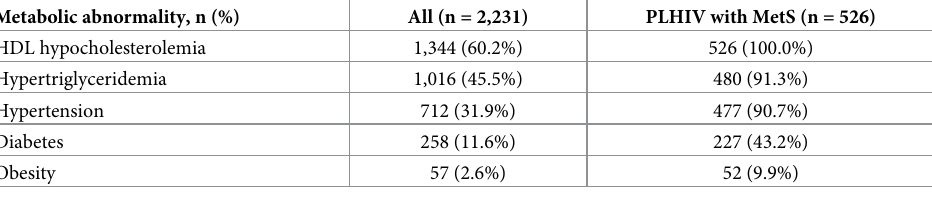
Table 2. Proportion with individual metabolic abnormalities among people living with HIV and those with meta- bolic syndrome on follow-up between 2015 and